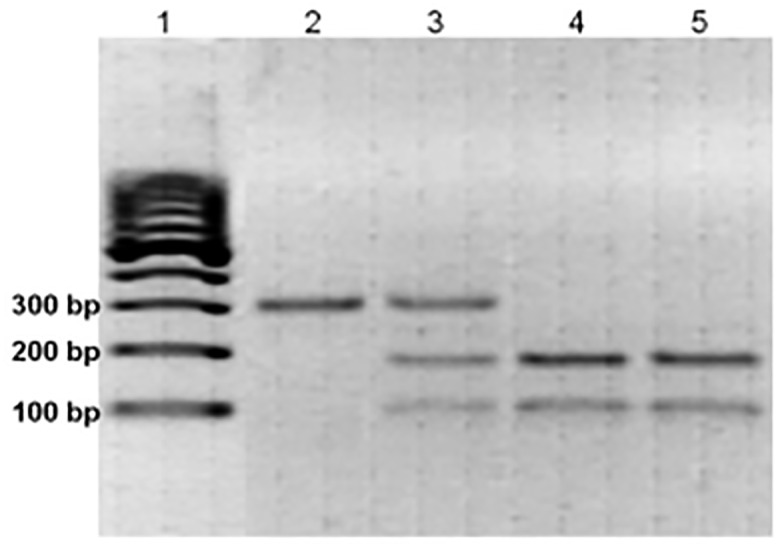
Representative sample of the genotyping for SDF1-3’G(801)A by PCR-RFLP.Msp I digestion of the PCR product of SDF1 gene. DNA molecular weight marker is shown in lane 1. Lane 2 represents sample at 302 bp denoting SDF1–3’homozygous (801)AA mutant genotype, lane 3 shows bands at 302, 202 and 100 bp denoting heterozygous mutant SDF1-3’(801)GA and lanes 4 and 5 at 202 and 100 bp denoting the wild type SDF1-3’(801)GG genotype.